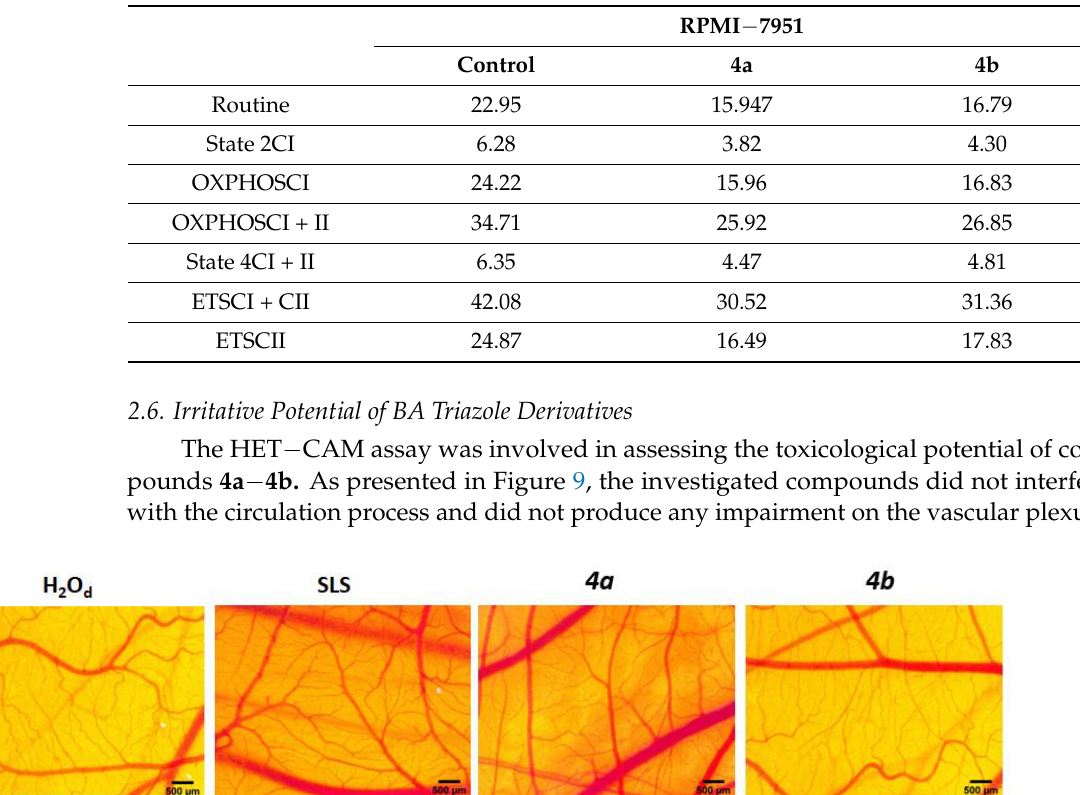
Table 2. Mitochondrial respiratory rates of RPMI − 9751 cells treated with compounds 4a and 4b .